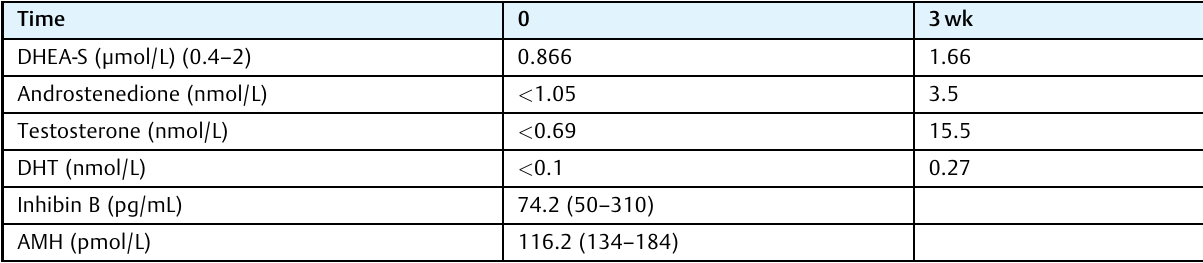
Table 3 Three-week Hcg test at age 9.5